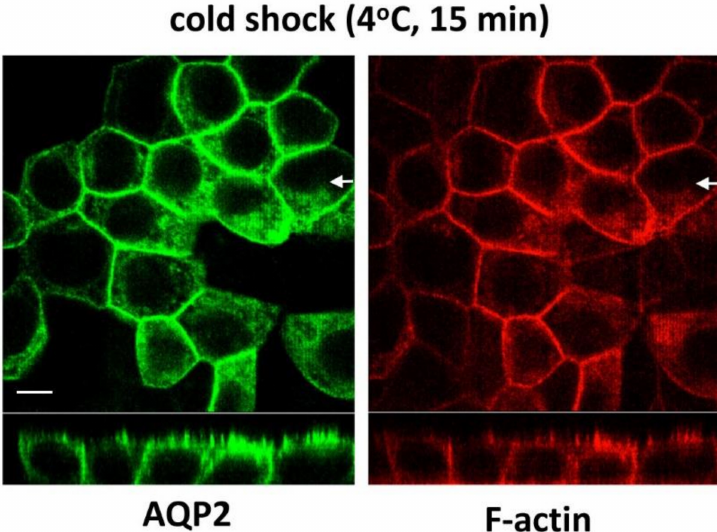
Figure 7. The e ff ect of cold shock on F-actin in polarized MDCK cells: polarized AQP2-MDCK cells were subjected to a cold shock (4 ◦ C for 15 min), and then, AQP2 and F-actin were immunostained. The larger panels represent confocal sections through the middle regions of each monolayer. The smaller horizontal strips at the bottom of each panel are Z-sections to show apical and basolateral membranes (taken in the plane indicated by the white arrows). After a brief cold shock, AQP2 accumulated in the basolateral membrane, with well-polymerized basolateral F-actin shown using Rh-phalloidin staining. The images are representative of three independent experiments. Bar = 5 µ m.